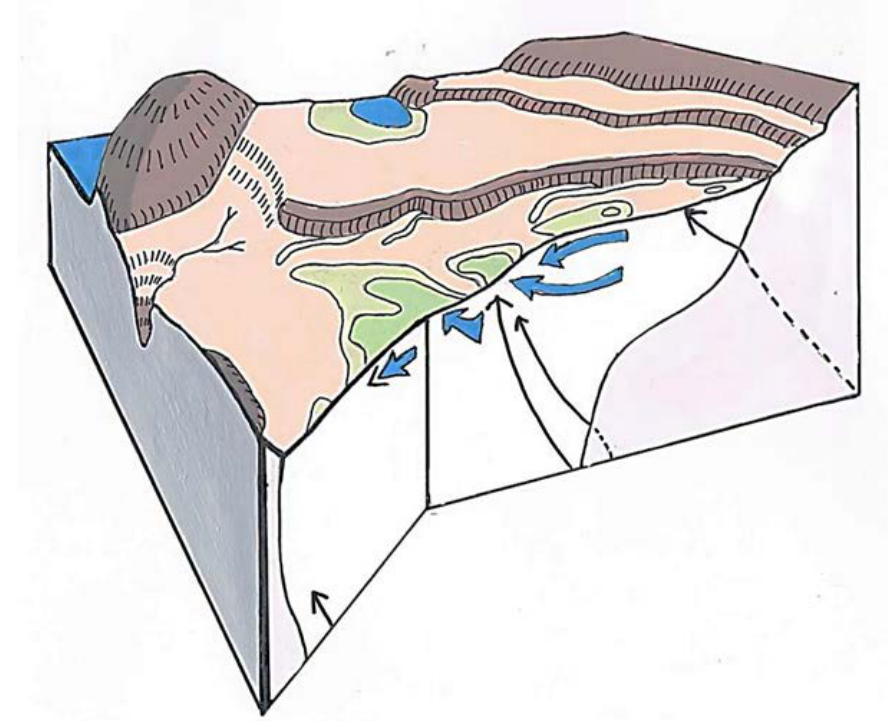
Figure 10. Conceptual model of groundwater flows in the study area. Groundwater flow occurs predominantly in the upper (less-decomposed) peat layers (large blue arrows). At several sites relatively base-rich groundwater emerges at the surface (thin black arrows), possibly from geological faults that enable preferential groundwater